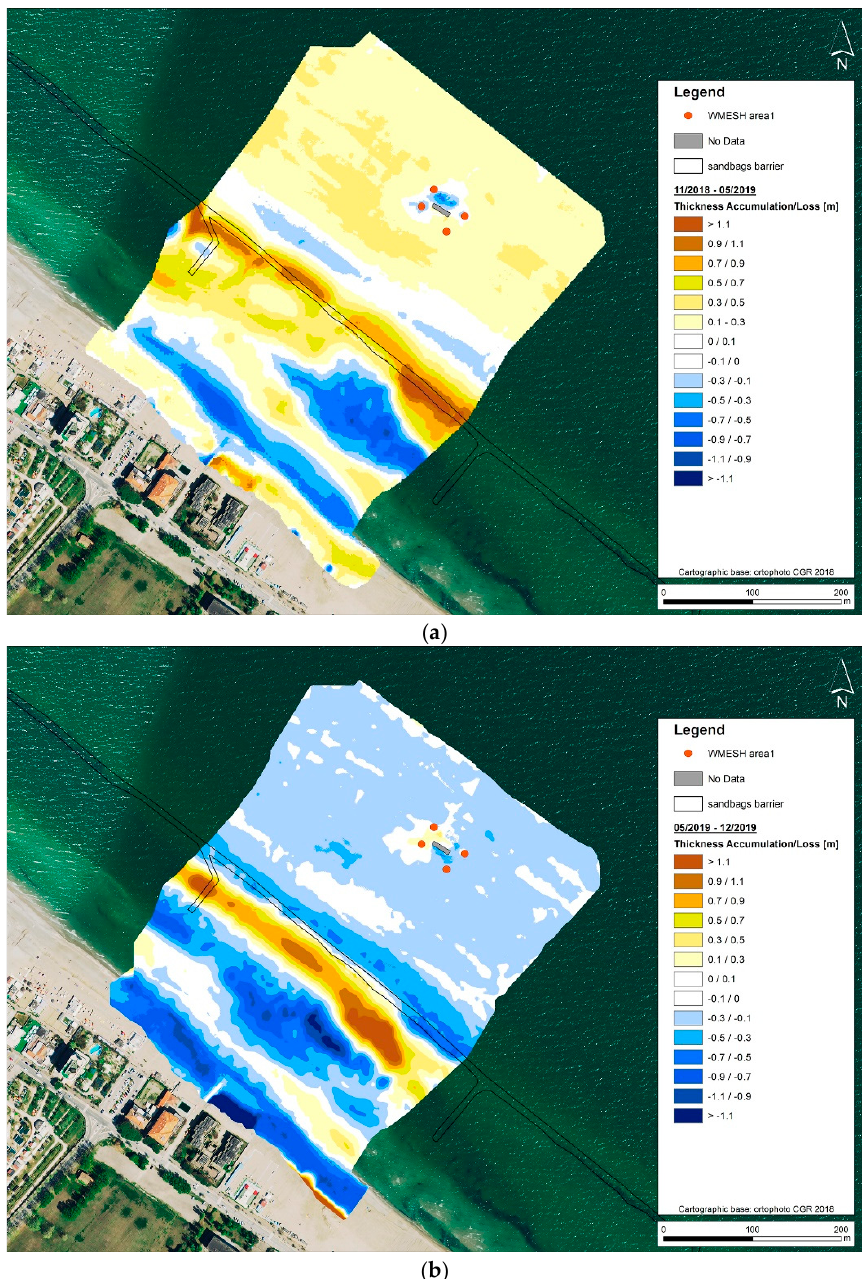
Figure 7. Difference maps between: ( a ) November 2018 and May 2019 DTMs; ( b ) May 2019 and December 2019